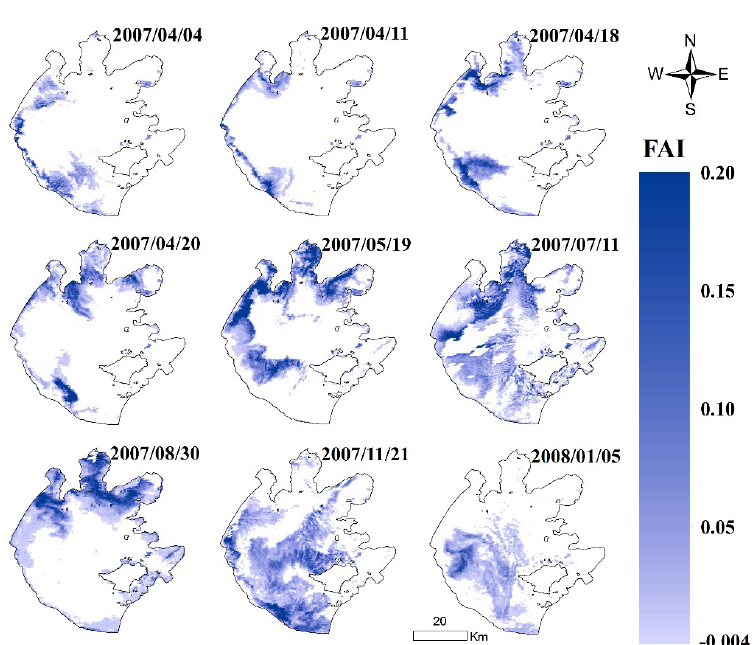
Figure 4. Evolution of cyanobacteria blooms in 2007.